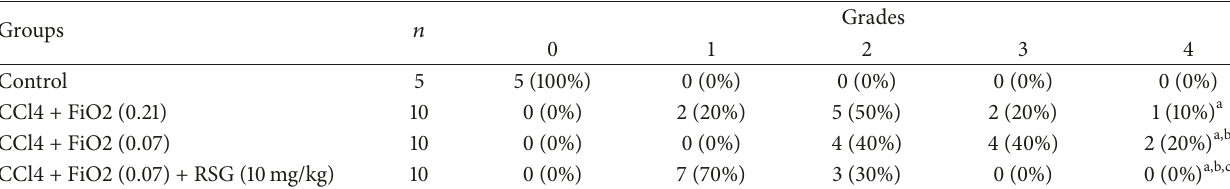
Table 1: Grades of fibrosis in rat liver.